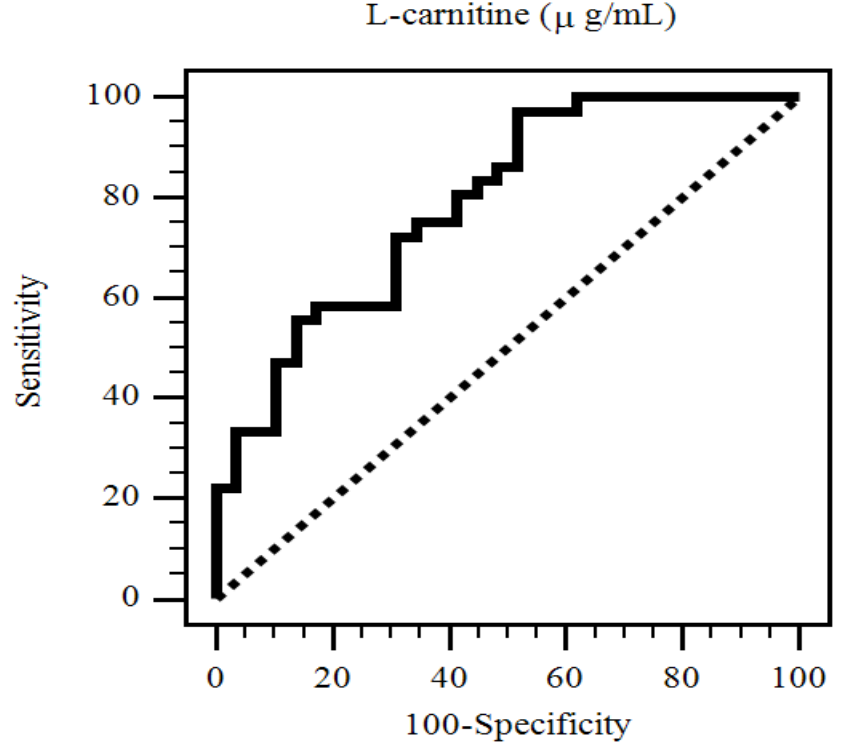
Figure 1. Receiver operating characteristic (ROC) curve analysis to predict peripheral arterial sti ff ness in 65 renal transplant recipients. The area under the ROC curve (AUC) indicates the diagnostic power of l -carnitine at predicting peripheral arterial sti ff ness in renal transplant recipients. The AUC for l -carnitine was 0.789 (95% confidence interval: 0.670–0.881, p < 0.001).